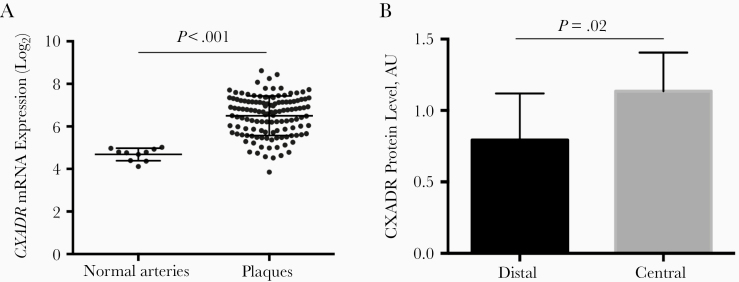
Up-regulation of coxsackievirus and adenovirus receptor (CXADR) in human carotid plaques. A, Plot graph showing CXADR messenger RNA (mRNA) expression in human carotid plaques (n = 127) compared with normal arteries (n = 10). B, Bar graph showing results from proteomic analysis of CXADR protein levels in plaques (central) versus nonplaque regions (distal) of human carotid arteries. Abbreviation: AU, arbitrary units.